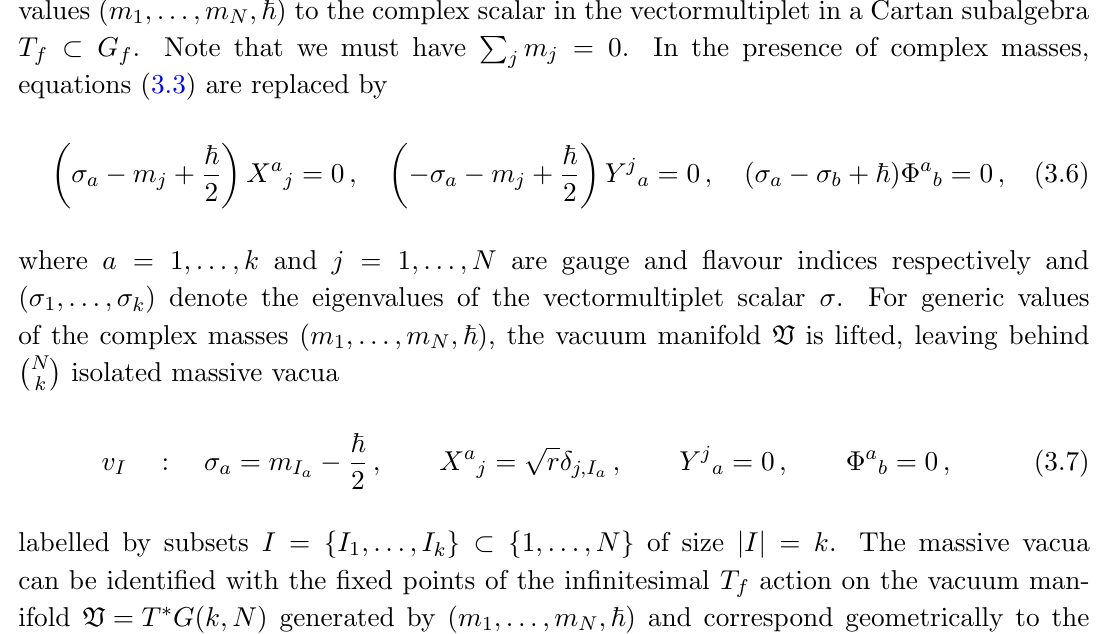
+ and f g f(cid:0)g